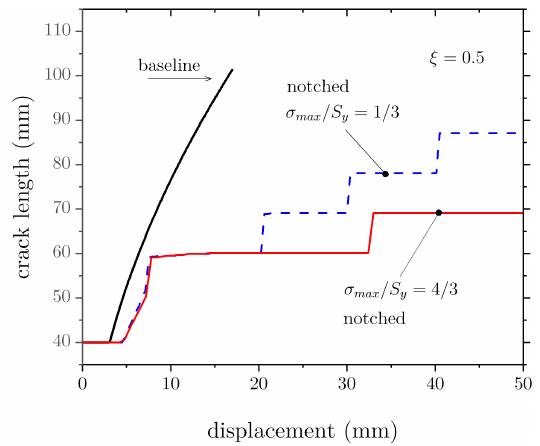
Figure 9. Effect of cohesive strength on the crack length versus displacement plots before and after the addition of